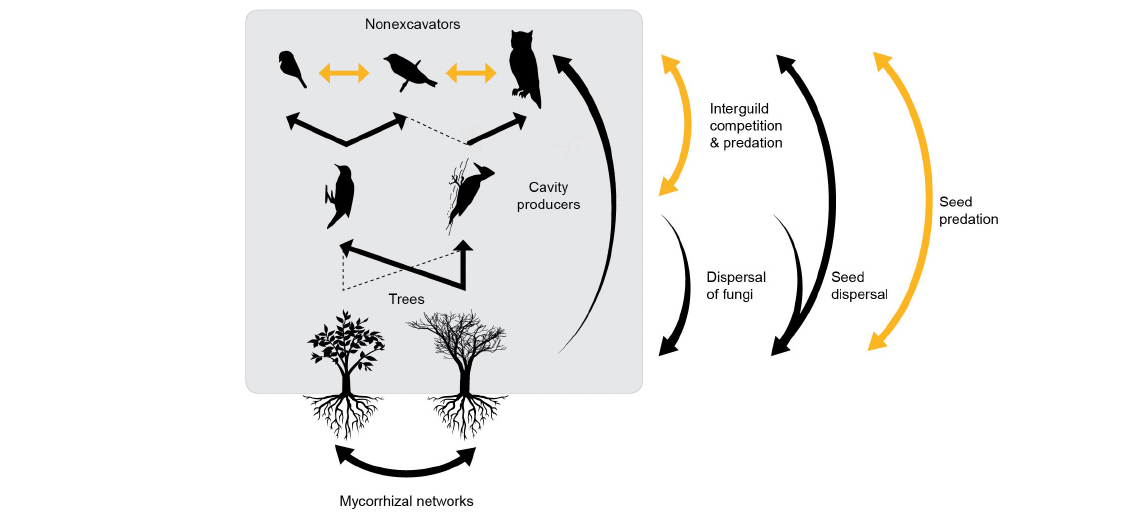
Fig. 1 . A simple conventional model of nest web (grey box) with positive (black) and negative (yellow) interactions among species (Martin and Eadie 1999). Cavities flow (straight black arrows) from trees to cavity producers, i.e., excavators or decay, to nonexcavators, which compete amongst themselves for the limited cavity resource (straight yellow arrows). Weaker links are shown with broken lines. Arrows outside the grey box highlight several important feedback loops beyond the conventional nest web model.